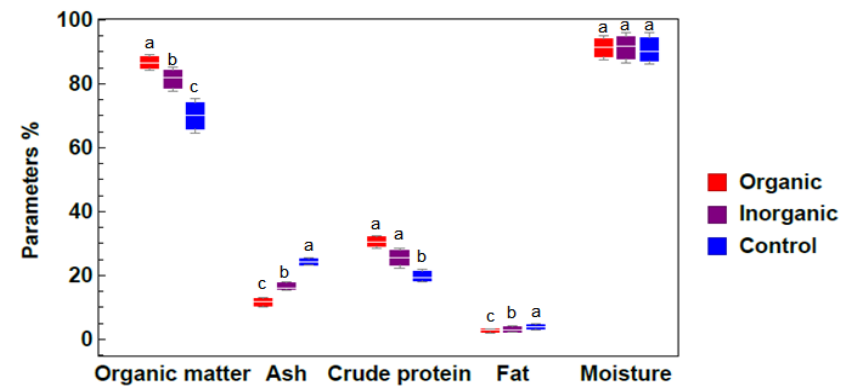
Figure 3. Biochemical composition of Azolla sp . samples exposed to different treatments (means ± standard errors from three independent experiments under different treatments: organic, inorganic and control). Different lowercase letters indicate significant differences between different treatments at p ≤ 0.05 .